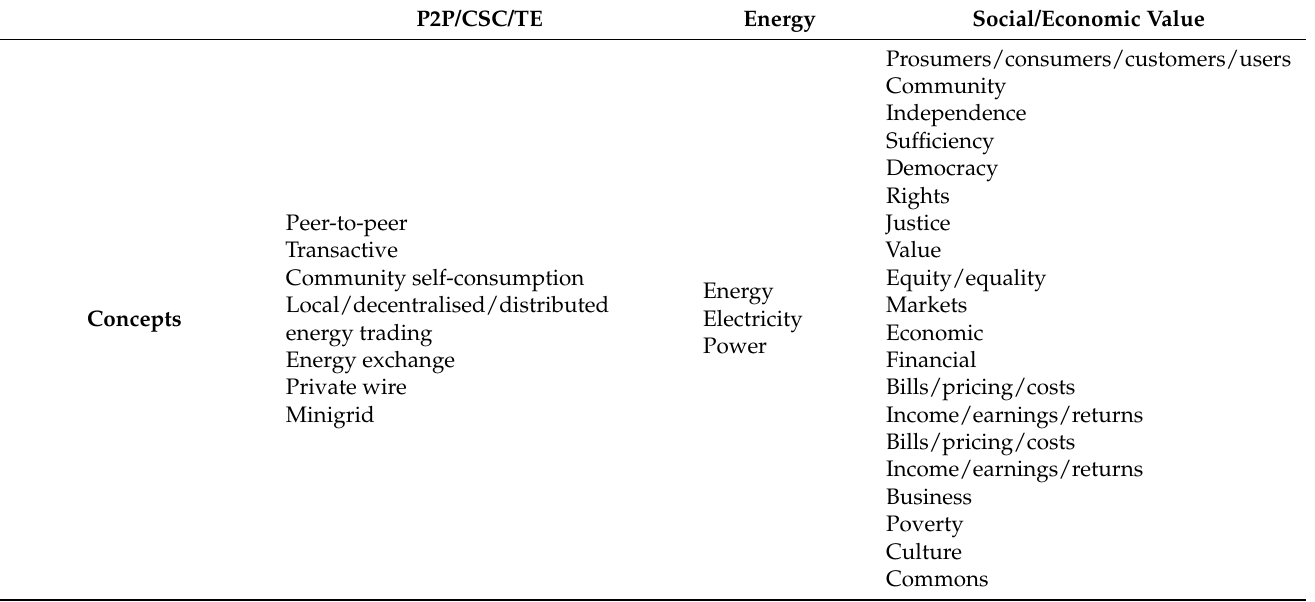
Table 1. The concepts and search terms used in the review, along with an example search string used in the database Scopus.